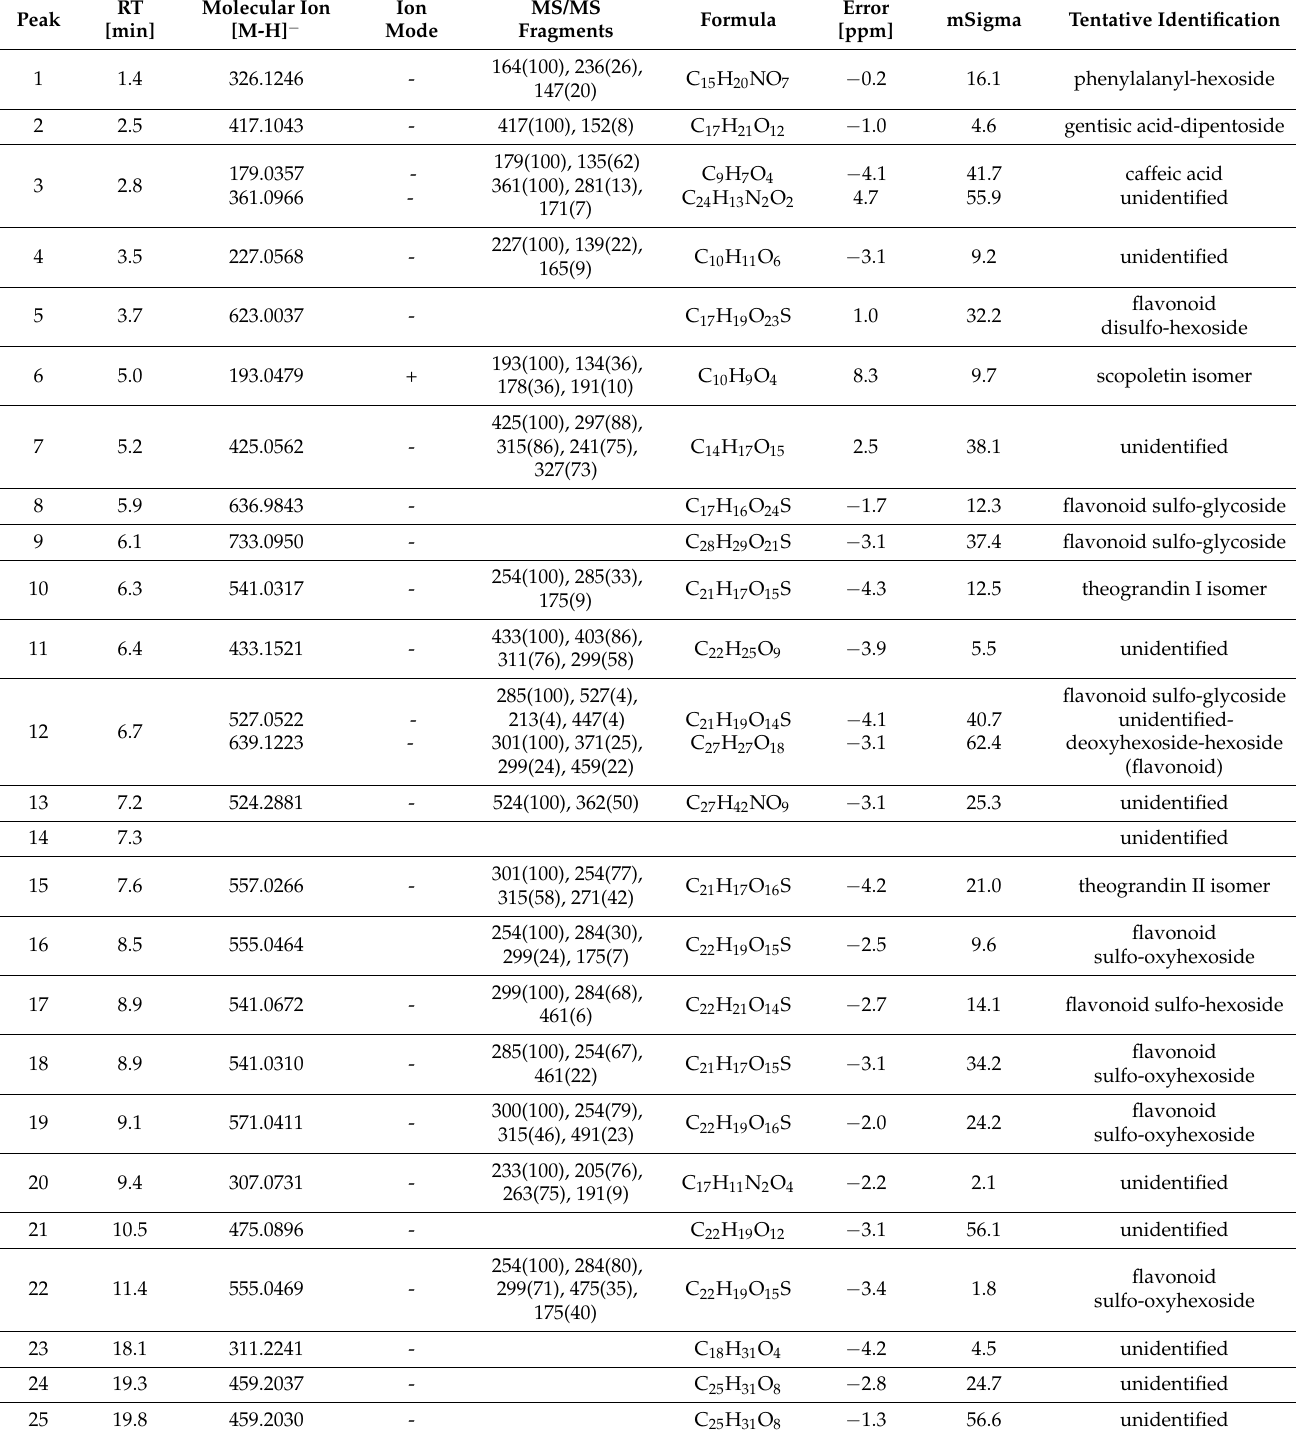
Table 9. Compounds identified in the marshmallow ( Althaea L.) extract using UHPLC-QTOF-MS/MS. Compound numbers correspond to those indicated in Figure